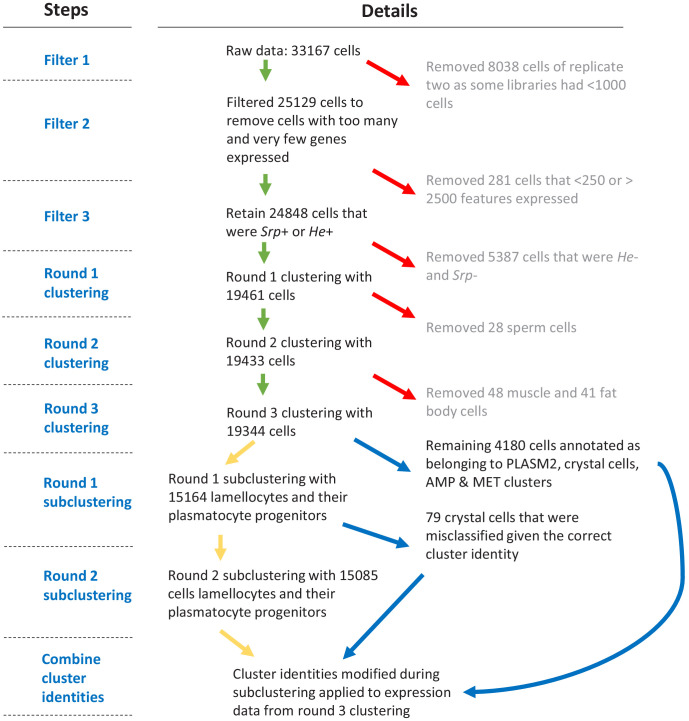
Flowchart of data filtering and clustering steps.Only cells expressing >250 features and <2500 features and cells that were either He+ or Srp+ were kept. Cells expressing high levels of sperm-cell, muscle, or fat body marker genes were identified during three rounds of clustering and removed. 19,344 cells remained after filtering. Two rounds of subclustering identified plasmatocyte progenitor and lamellocyte clusters and these identities replaced those attained from round three clustering for relevant cells.